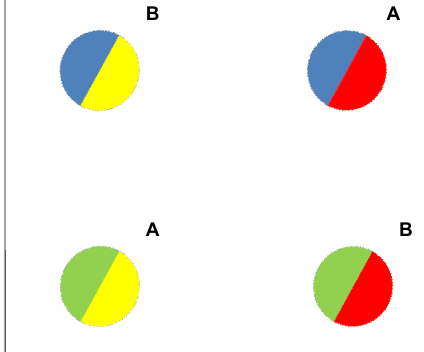
Figure 9. An exclusive-or (XOR) category task. Category A members have both red and blue sectors or neither and both yellow and green sectors or neither. Category B members have both blue and yellow sectors or neither and both red and green sectors or neither. Single sectors do not predict category membership and categories do not share family resemblance.